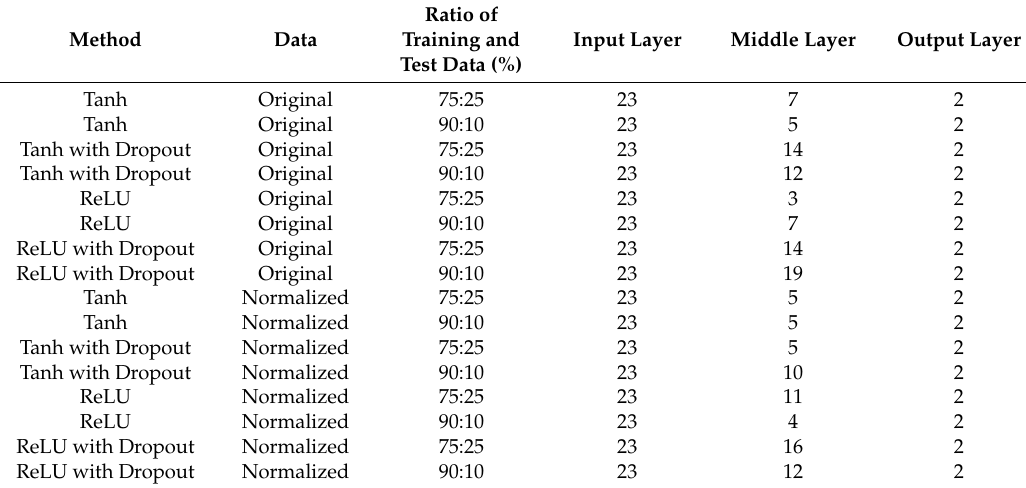
Table A1. Number of units in middle layer for NN.